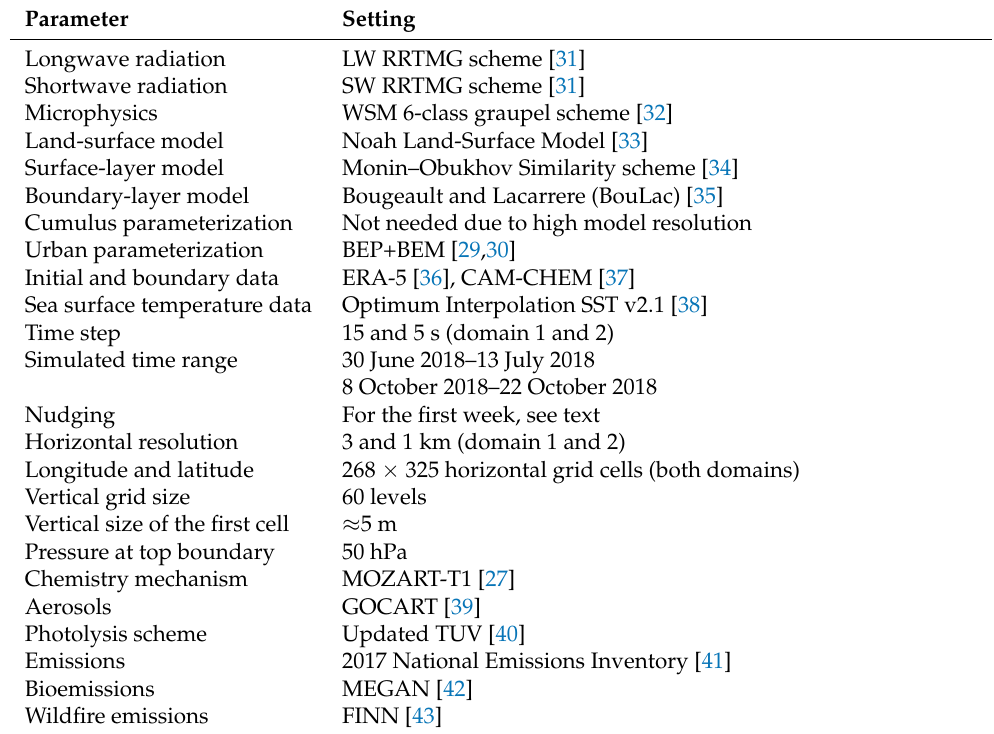
Table 1. Configuration of